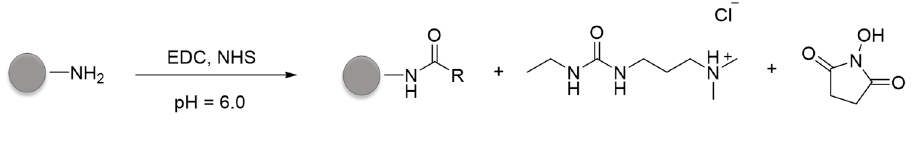
Figure 4. Conjugation of NH 2 -NPs with hyaluronic acid (HA).